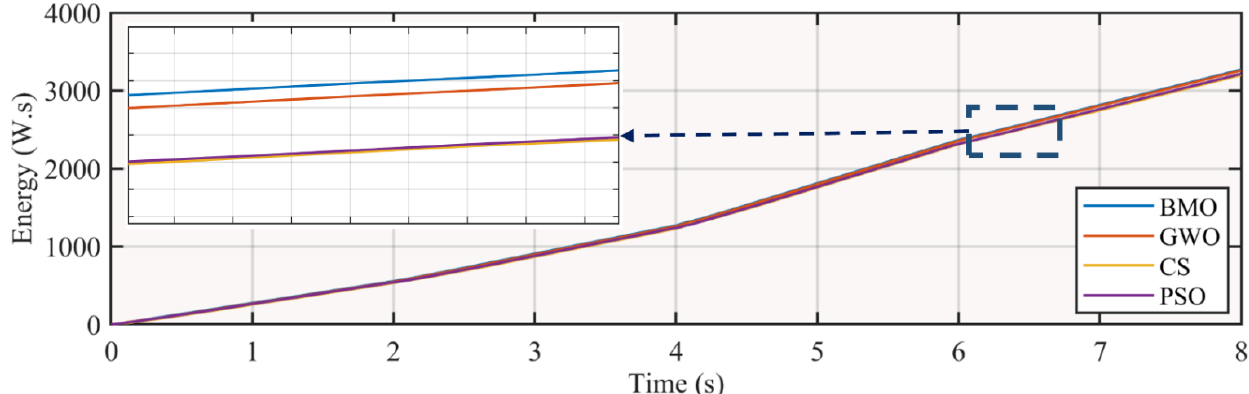
Figure 22. Competing techniques energy in Case-2.